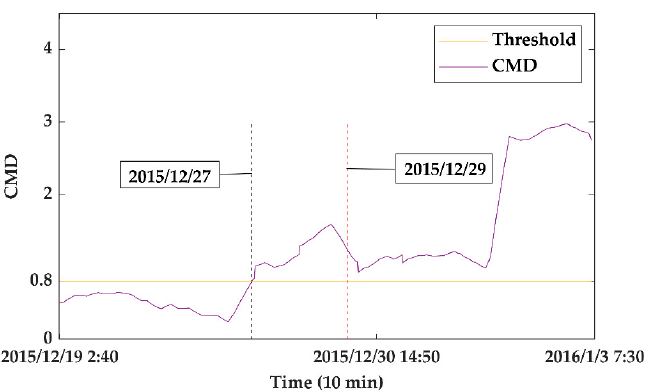
Appl. Sci. 2021 , 11 , x FOR PEER REVIEW Figure 7. The changing curve of the CMD for hydropower units in case 1. Figure 7. The changing curve of the CMD for hydropower units in case 1.